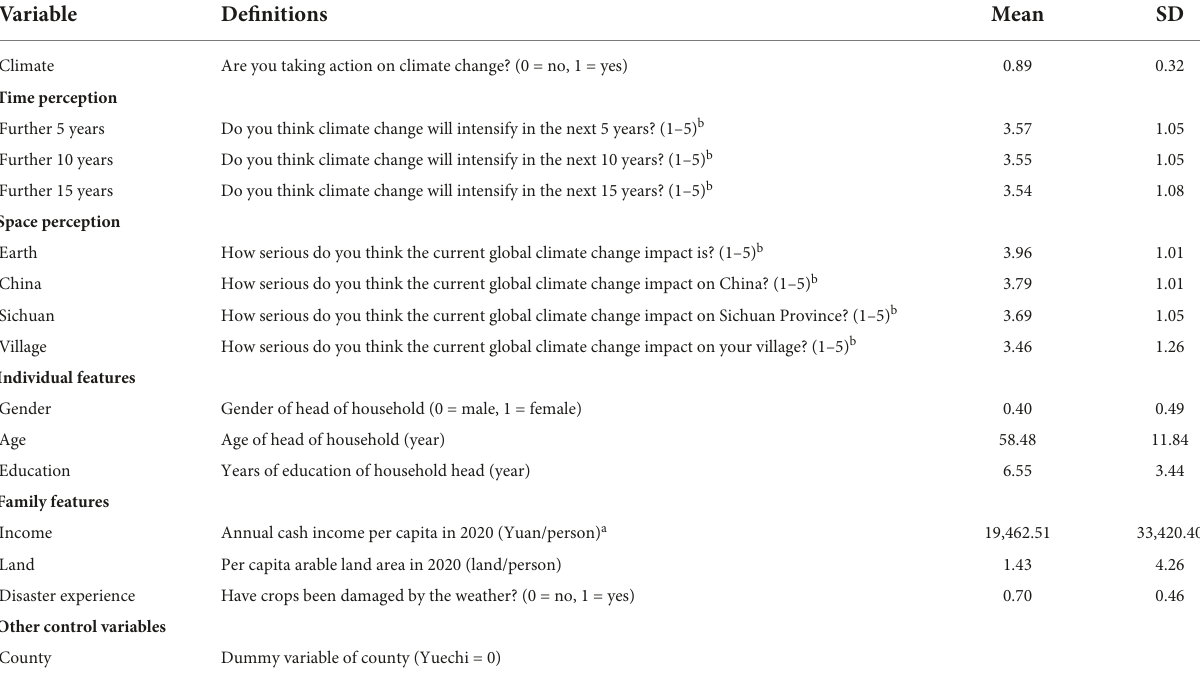
TABLE 1 Variable definition and descriptive